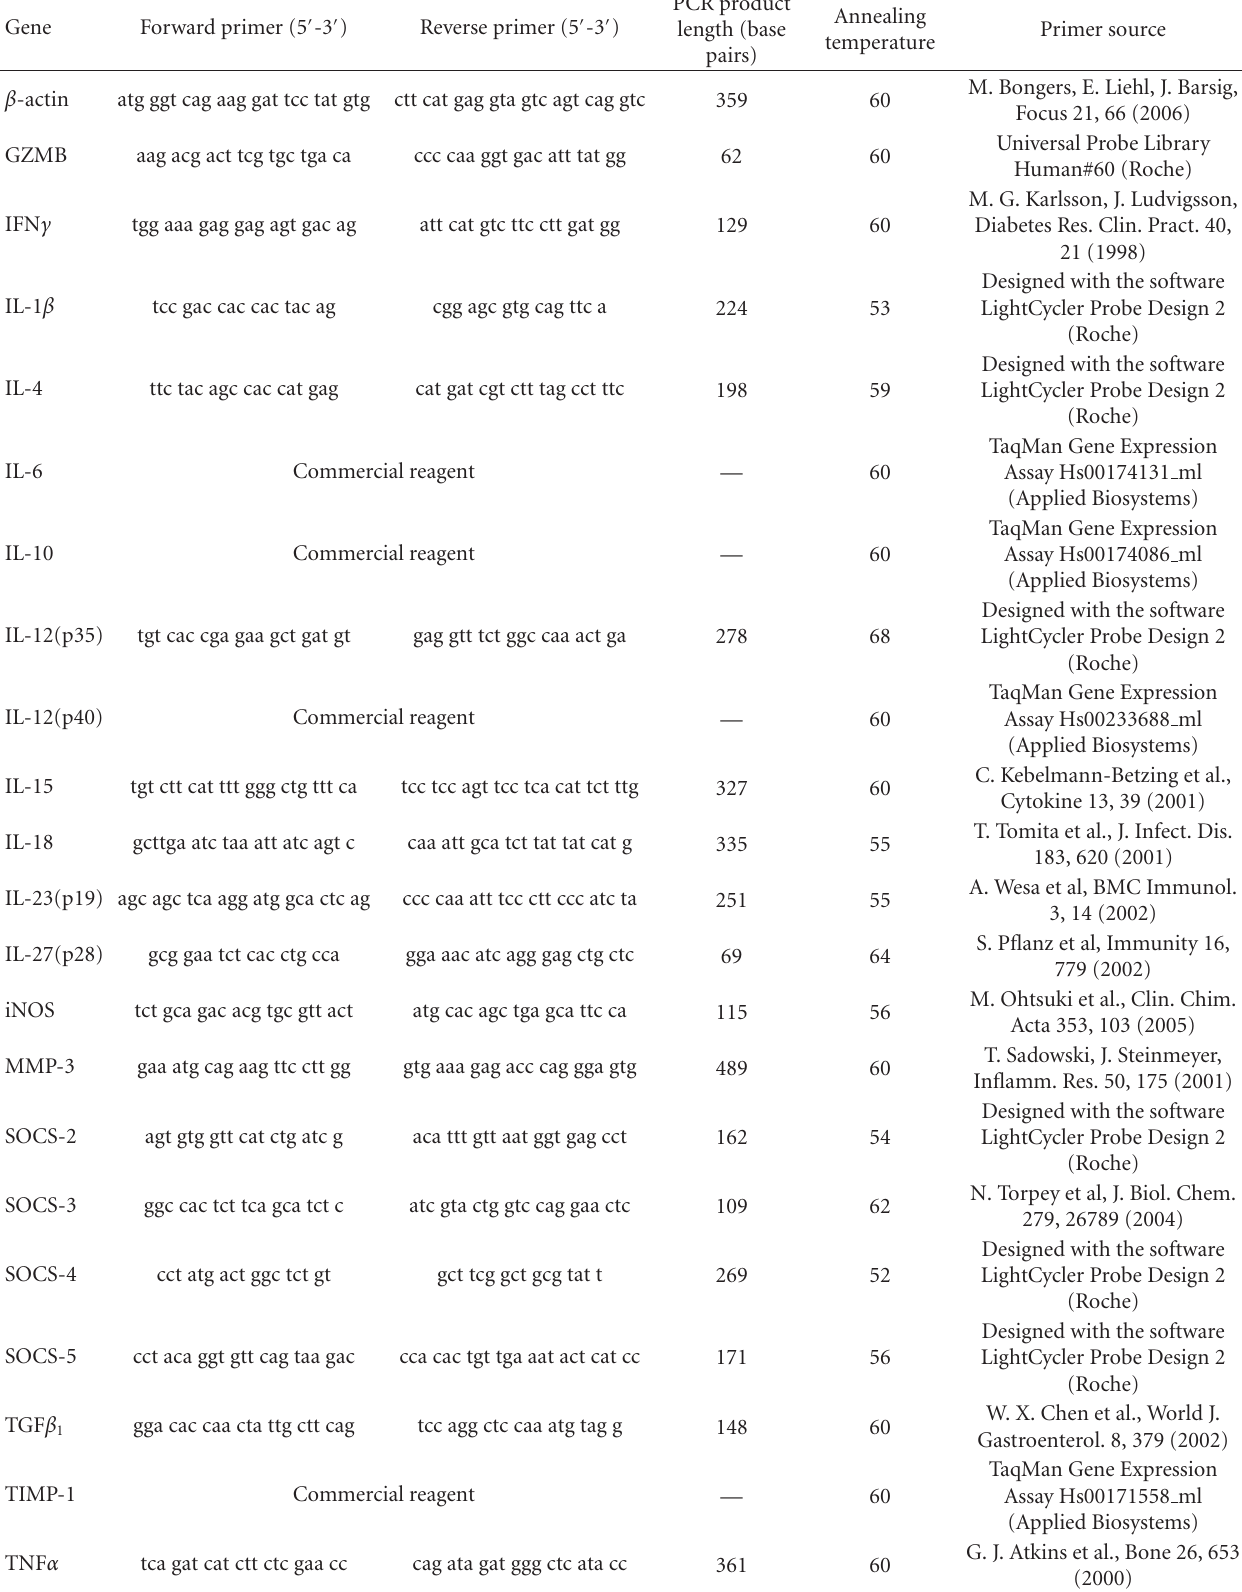
Table 2: Real-time PCR information. Primer sequences, PCR products length, temperature of annealing, and source of the primers used for Quantitative